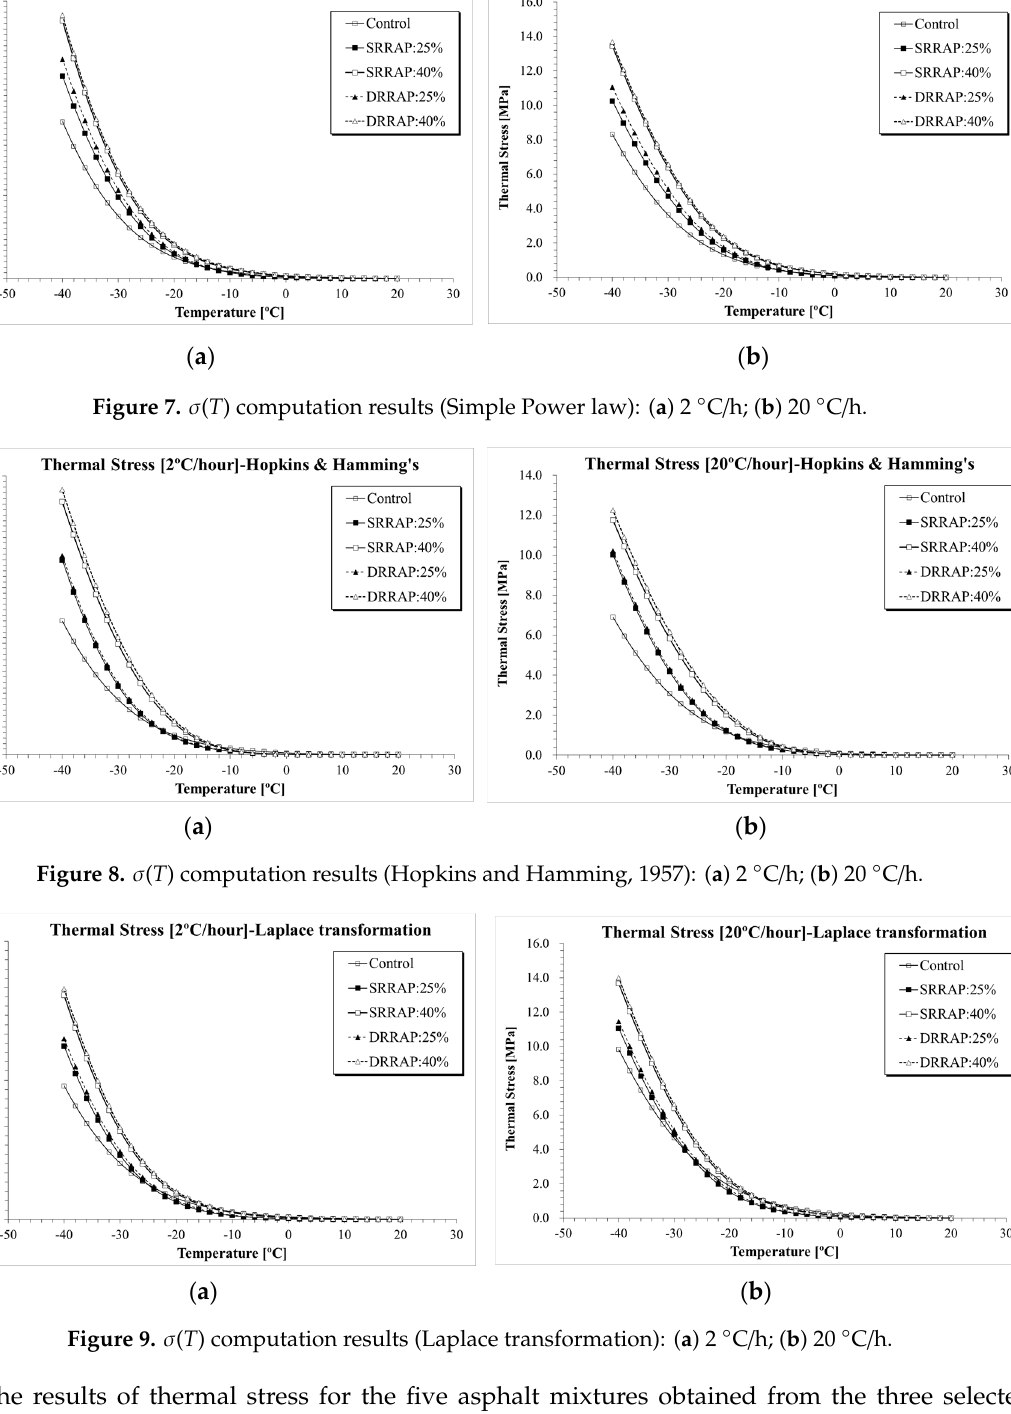
Figure 9. σ ( T ) computation results (Laplace transformation): ( a ) 2 °C/h; ( b ) 20 °C/h.